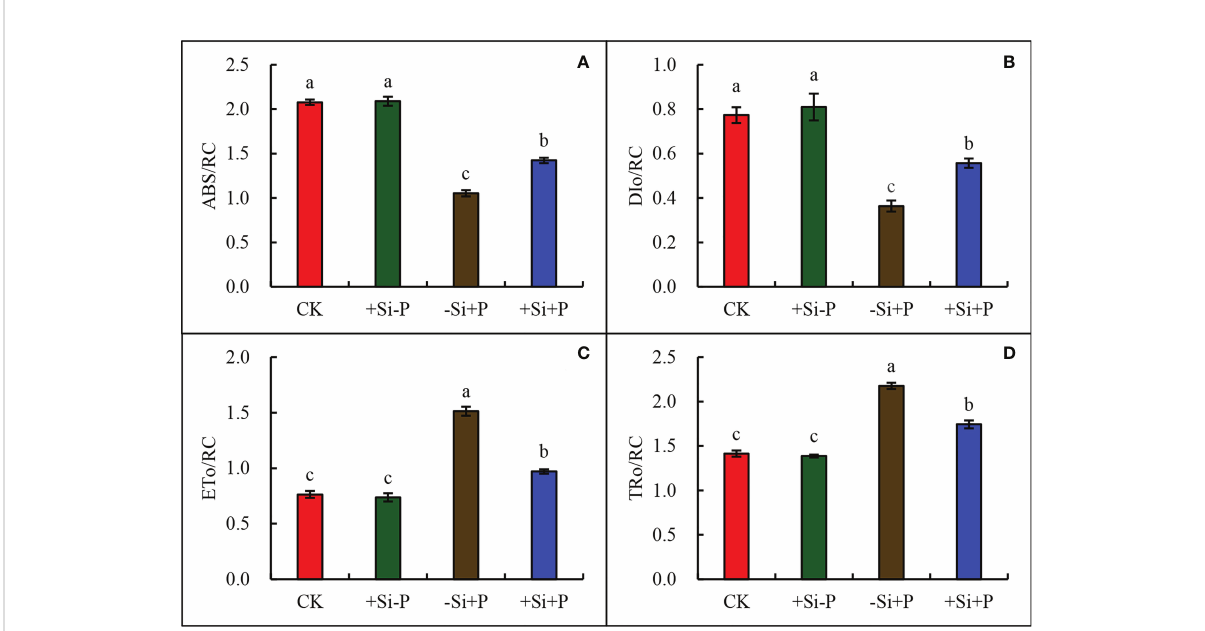
FIGURE 7 Effect of Si application and Pga inoculation on ABS/RC (A) , DIo/RC (B) , ETo/RC (C) , and TRo/RC (D) of oat leaves. CK, no Si application and no Pga inoculation; +Si-P, 1.5 mmol·L – 1 Si application and no Pga inoculation; -Si+P, no Si application and Pga inoculation; +Si+P, 1.5 mmol·L – 1 Si application and Pga inoculation. Data are expressed as mean ± SE (n=3). According to Duncan ’ s multiple comparison tests among treatments, different letters on bars show signi fi cant differences at 0.05 level of